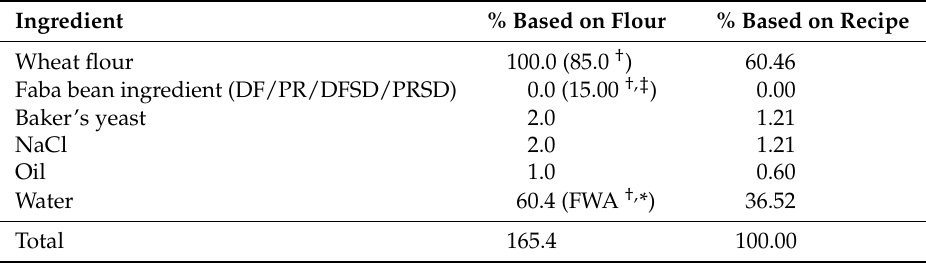
Table 1. Recipes for control and faba bean